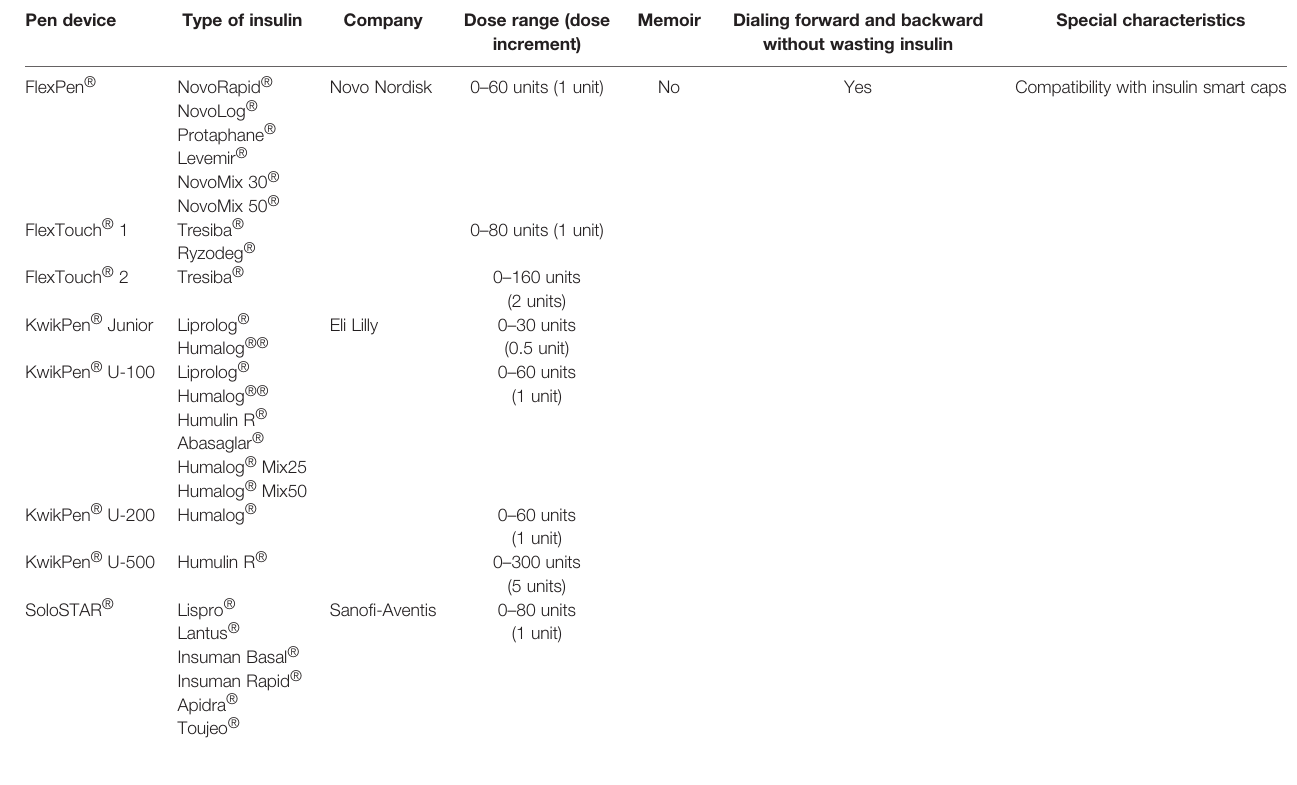
TABLE 4 | Technical characteristics of pre fi lled insulin